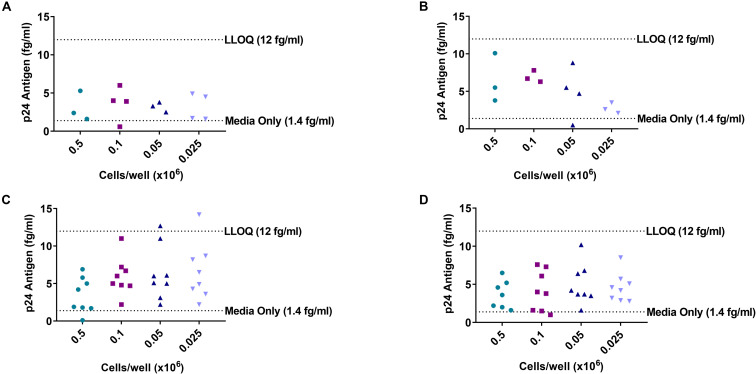
Limiting dilution culture of uninfected donor PBMC reveals background noise of Simoa. PBMC from an uninfected donor were stimulated in limiting dilution with PHA/IL-2 and irradiated PBMC or treated with low amount of IL-2 only. Cultures were either targeted with PHA blasts or no targets were added. Supernatant were harvested at day 8 and HIV p24 assayed by Simoa. (A) Low IL-2 treated/no targets added. (B) Low IL-2 treated/cultures targeted with PHA blasts. (C) PHA stimulated/no targets added. (D) PHA stimulated/cultures targeted with PHA blasts. Each dot represents a well at the indicated cell dilution. LLOQ, lower limit of quantitation.